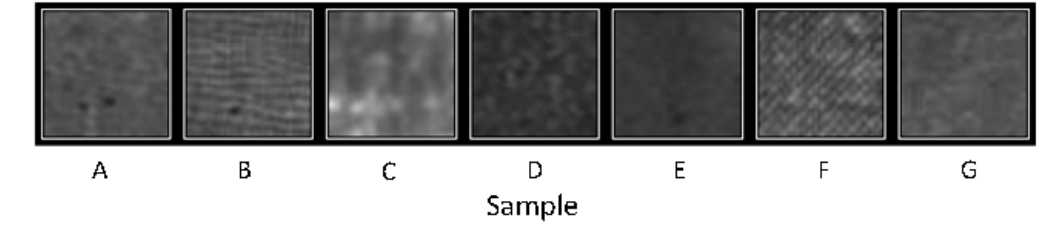
Figure 6. Samples textures.